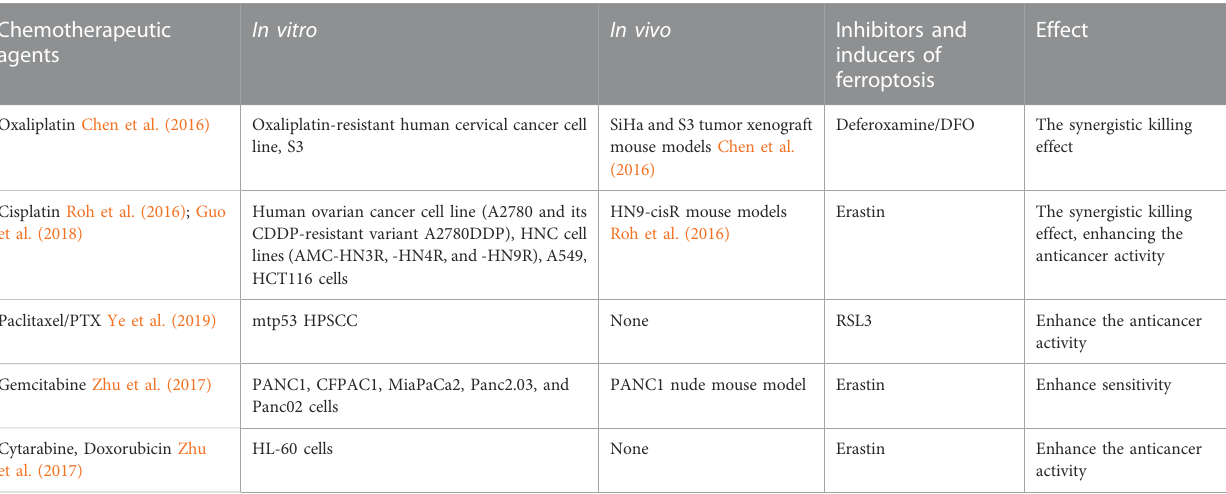
TABLE 1 Overview of ferroptosis-associated chemotherapeutic agents in